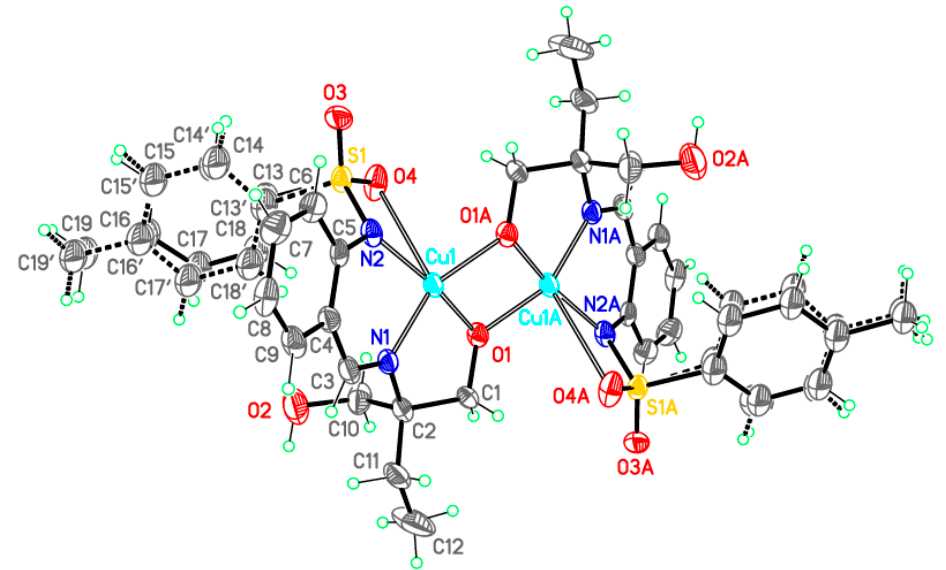
Figure 6. Molecular structure of 3-Cu . Displacement ellipsoids are shown at the 50% probability level. The label A denotes symmetrically equivalent atoms generated by the inversion centre. Dashed lines indicate secondary Cu . . . O interactions. The alternative positions of the disordered p -tolyl fragments with the lesser occupations are shown by dashed lines and the respective atoms are primed. Selected bond lengths and angles (Å and ◦ ): Cu1–O1 1.918(3), Cu1–O1A 1.948(2), Cu1–N1 1.952(3), Cu1–N2 1.949(3), Cu1 ··· O4 2.862(3), Cu1 ··· Cu1A 2.9484(10), O1–Cu1–O1A 80.62(11), O1–Cu1–N1